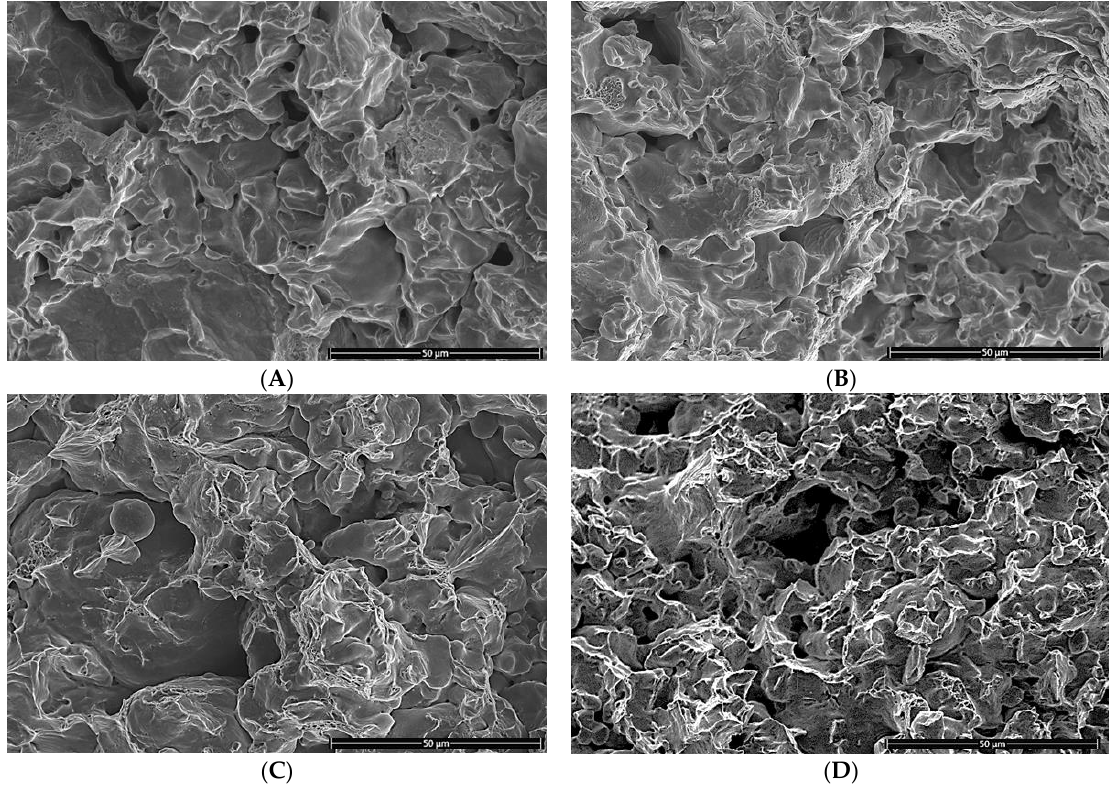
Figure 9. Fracture micrographics by SEM of sintered samples at ( A ) 835 °C at 700 MPa, ( B ) 835 °C at 600 MPa, ( C ) 835 °C at 700 MPa and ( D ) 820 °C at 500 MPa (magnification bars are 50 μm).